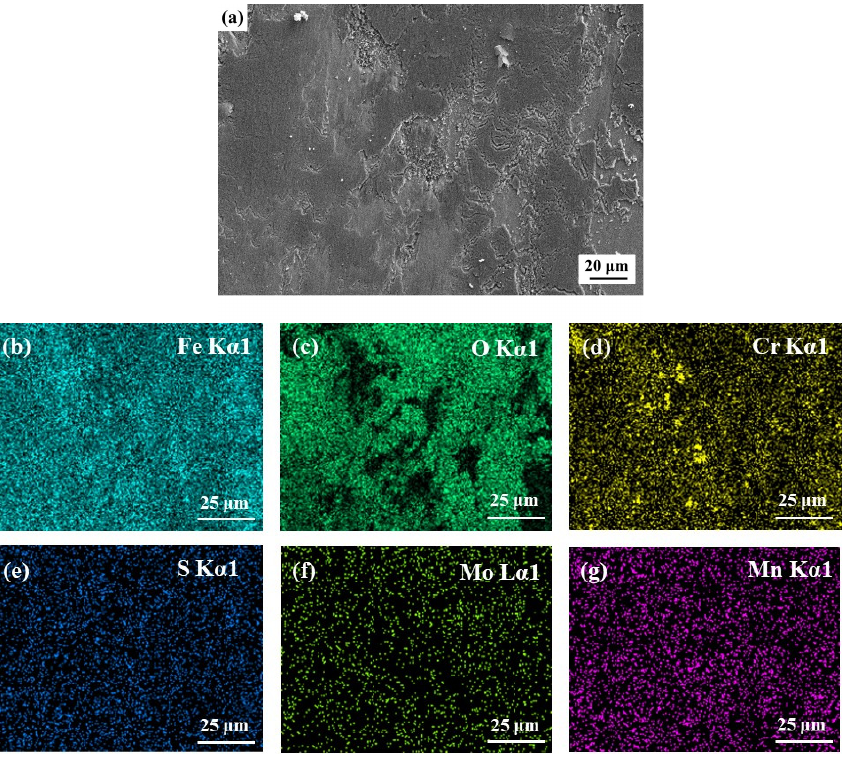
Figure 14. Wear morphology ( a ) and EDS elemental maps ( b – g ) of SLD-MAGIC under a normal load of 70 N.